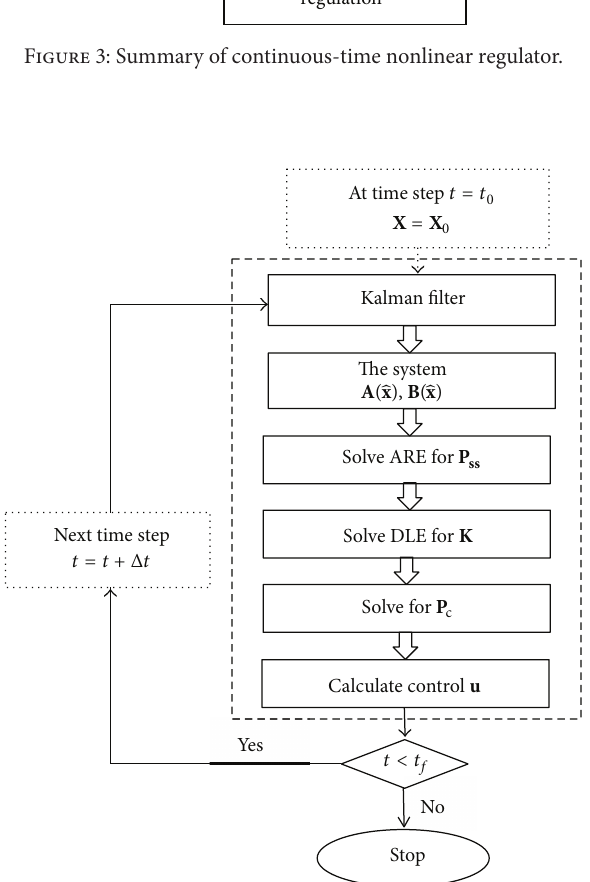
Figure 4: Flow chart of finite-horizon differential SDRE regulation technique for stochastic